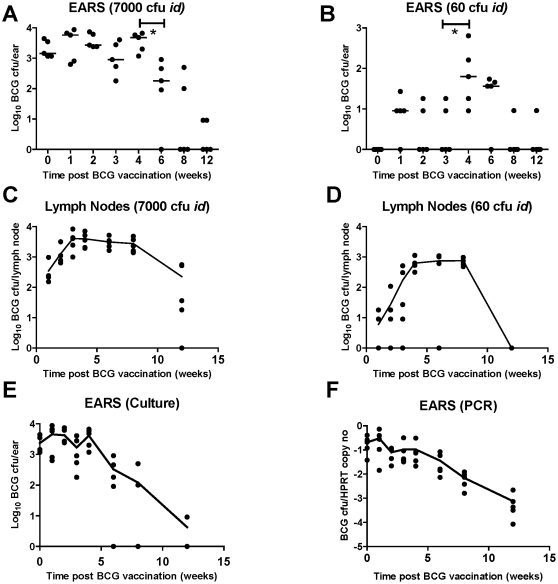
Timescale showing BCG persistence in the ears and LNs of id-injected mice up to 12 weeks post immunization.Log BCG CFU in the ears (estimated by culture) are shown for (a) the high dose group (7000 CFU id); and (b) the low dose group (60 CFU id). Log BCG CFU in the auricular LNs are shown in (c) the high dose group (7000 CFU id); and (d) the mid dose group (60 CFU id). Datasets include individual data points for each mouse; the bars represent the median per group in (a) and (b), and a line connects the means for each group in (c) and (d). * indicates P<0.05. Both ears and LNs were homogenized and plated onto 7H11 Middlebrook agar. Log BCG CFU in the ears estimated by culture (e) and BCG genome copies/mHPRT copies estimated by PCR (f) are shown in a timescale for the high dose group, up to 12 weeks post BCG immunization. Quantitative PCR was performed with BCG-specific primers. Individual data points are shown for each mouse with a line connecting the means for each group.